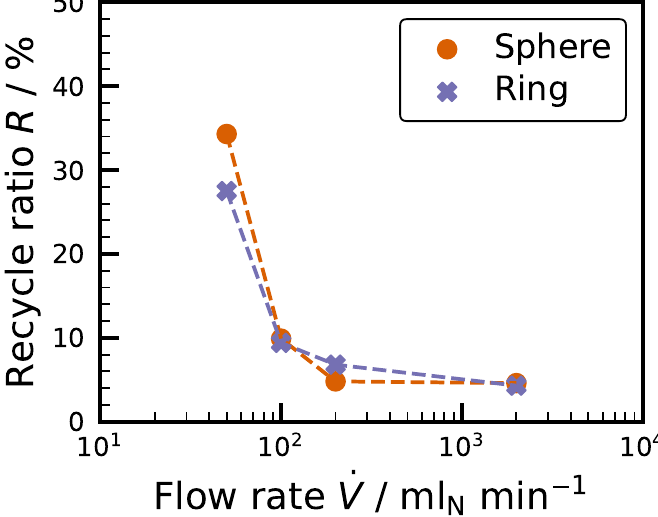
Figure 9. Recycle ratio R over volumetric flow rate of the CRN model. F (cid:48)